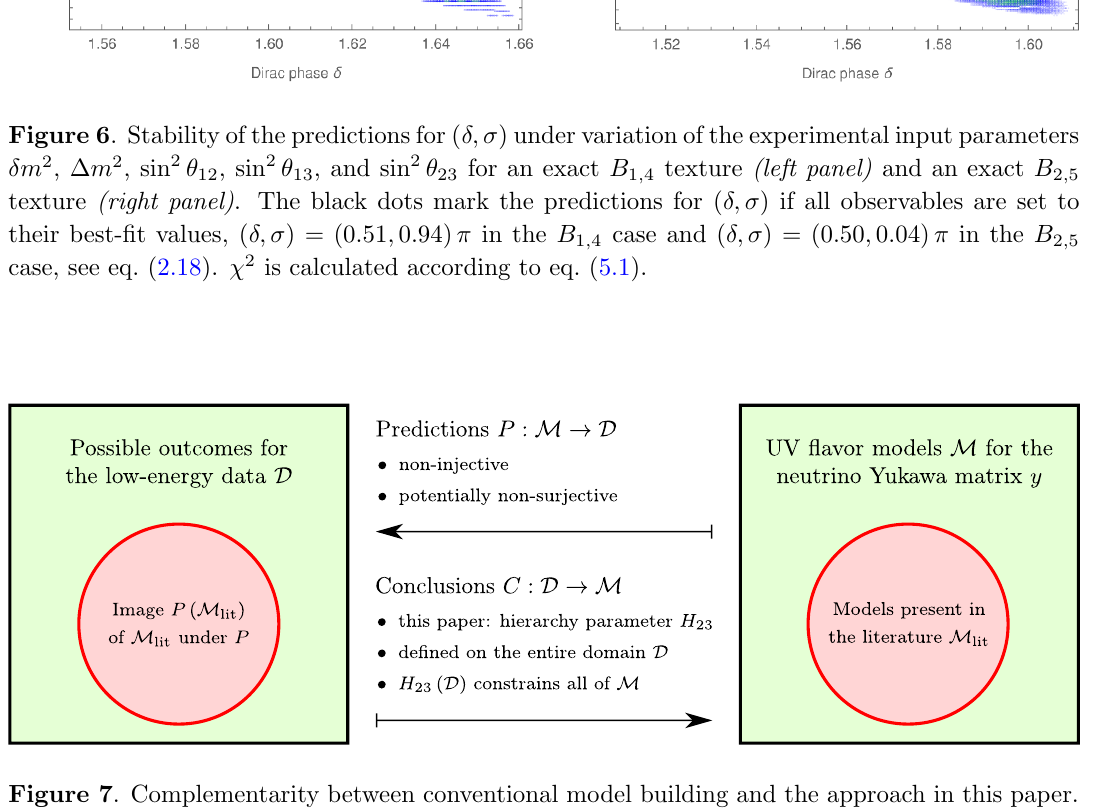
Figure 7 . Complementarity between conventional model building and the approach in this paper. Top-down model building (right to left) typically makes non-injective predictions for the outcome of experimental measurements. Depending on the speci(cid:12)c assumptions made when building UV (cid:13)avor models, one may not have a (cid:12)tting model at hand for each conceivable experimental result. Meanwhile, it is clear that the list of (cid:13)avor models in the literature is not exhaustive and that there are still many models that await to be worked out. In our bottom-up approach (left to right) ,